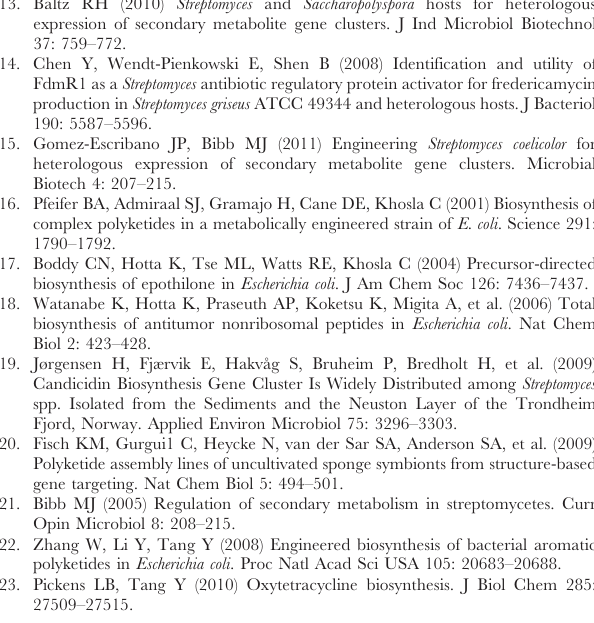
Table S2 List of putative s 54 promoters identified from Table S3 List of PKS, NRPS and NRPS/PKS gene clusters with the associated s 54 promoters identified from our bioinformatics analysis. Table S4 Tabulated number of PKS, NRPS and NRPS/ PKS gene clusters with one of more s 54